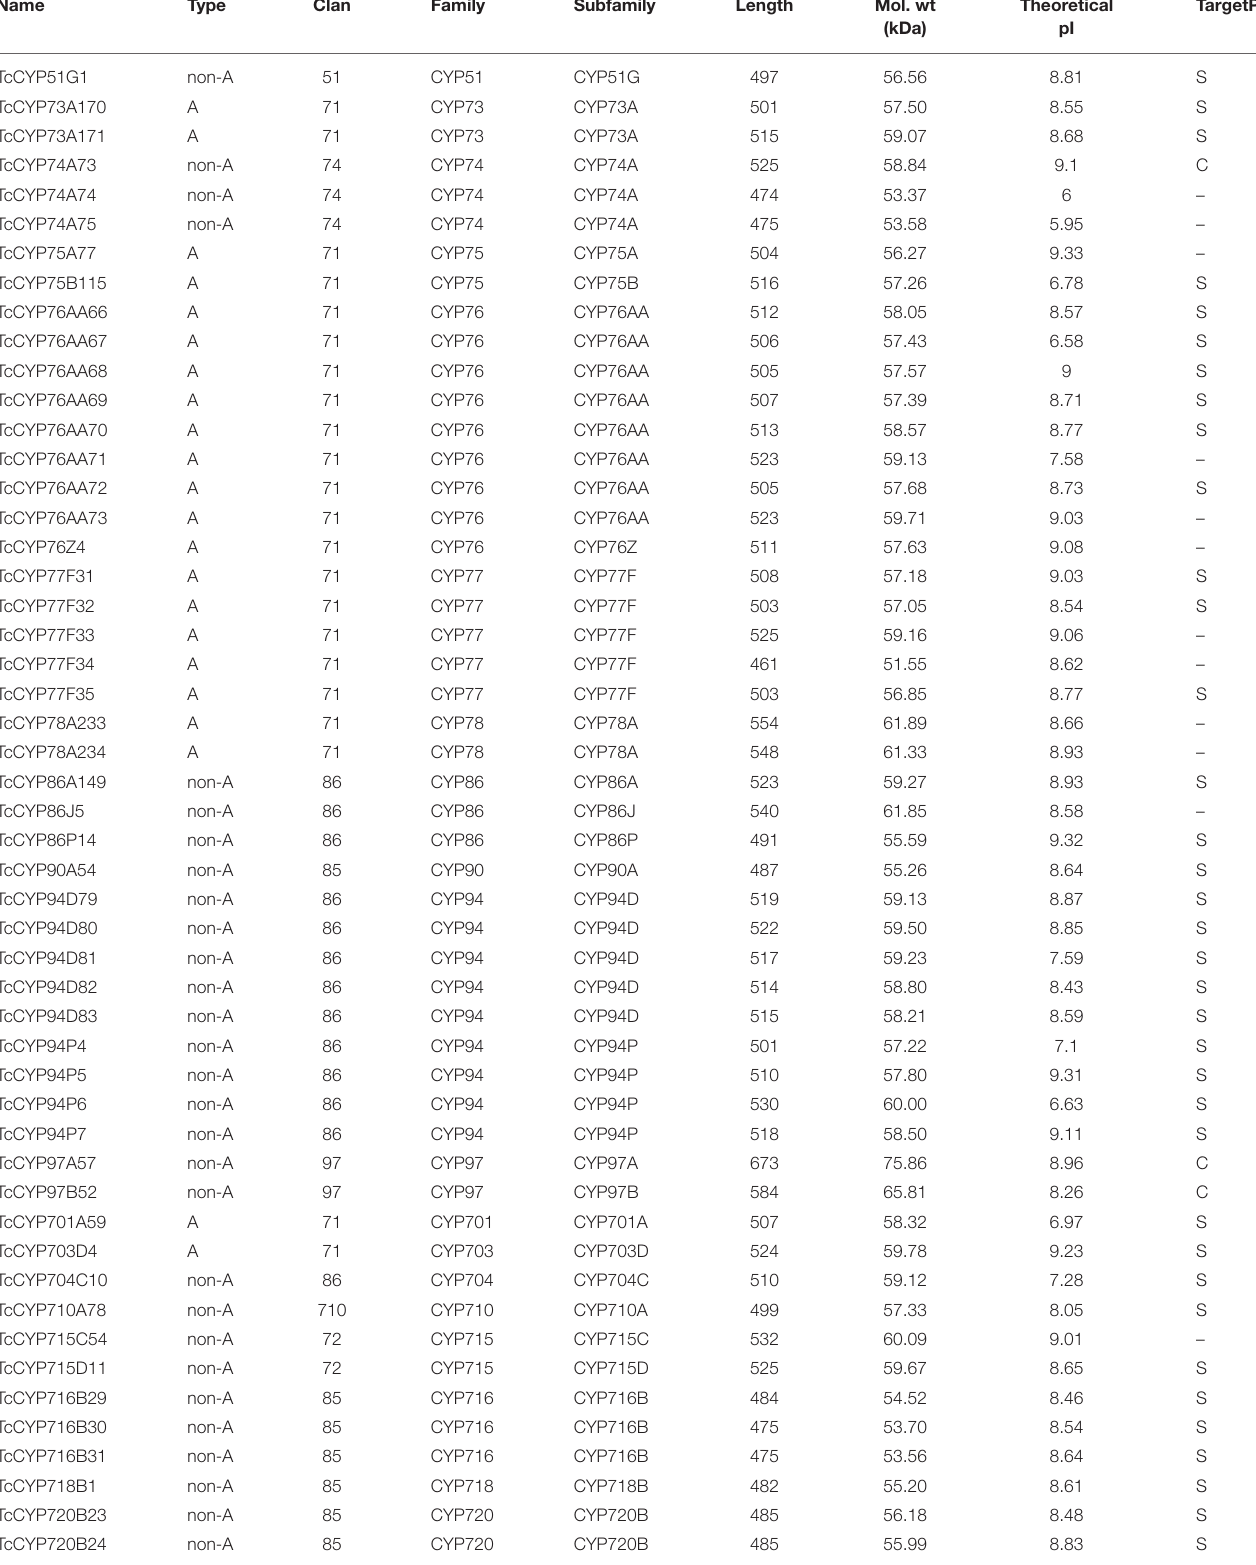
TABLE 2 | List of full-length CYP450s of T. chinensis identified in this